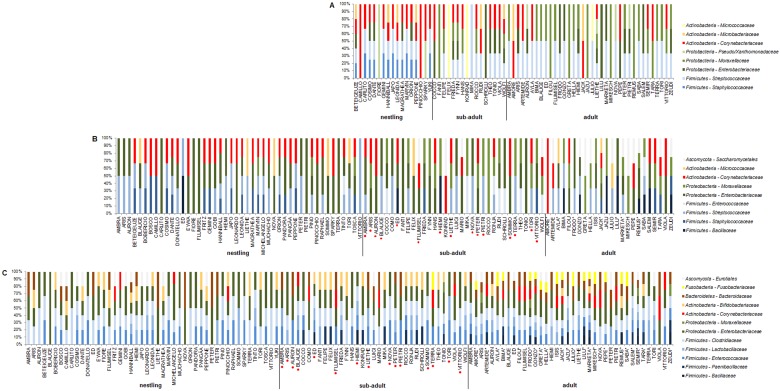
Relative proportion of predominant bacterial families and fungal orders detected in individual birds of different age classes.The figures illustrate the number of genus-level phylotypes within bacterial families/fungal orders detected in each sample of individuals, not the relative abundance of these phylotypes. Only bacterial families/fungal orders with at least 10% abundance in one age class are shown. Were two samples/individual (*) analysed (collected at different sampling times), results were accumulated. Hand-raised sub-adults are labelled with a red dot, parent-raised sub-adults are not labelled; A: choana, B: crop, C: cloaca.